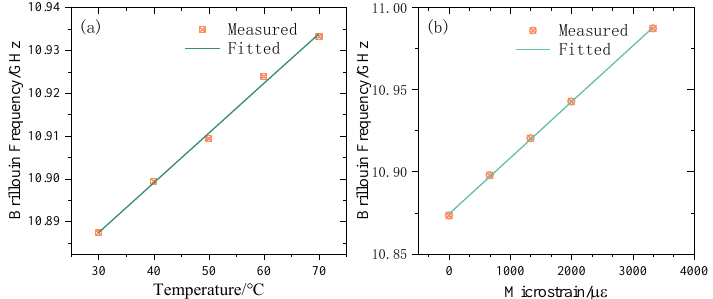
Figure 3. Schematic diagram of the fiber temperature and strain coefficient fitting. ( a ) BFS-temperature fitting curve ( b ) BFS-strain fitting curve.